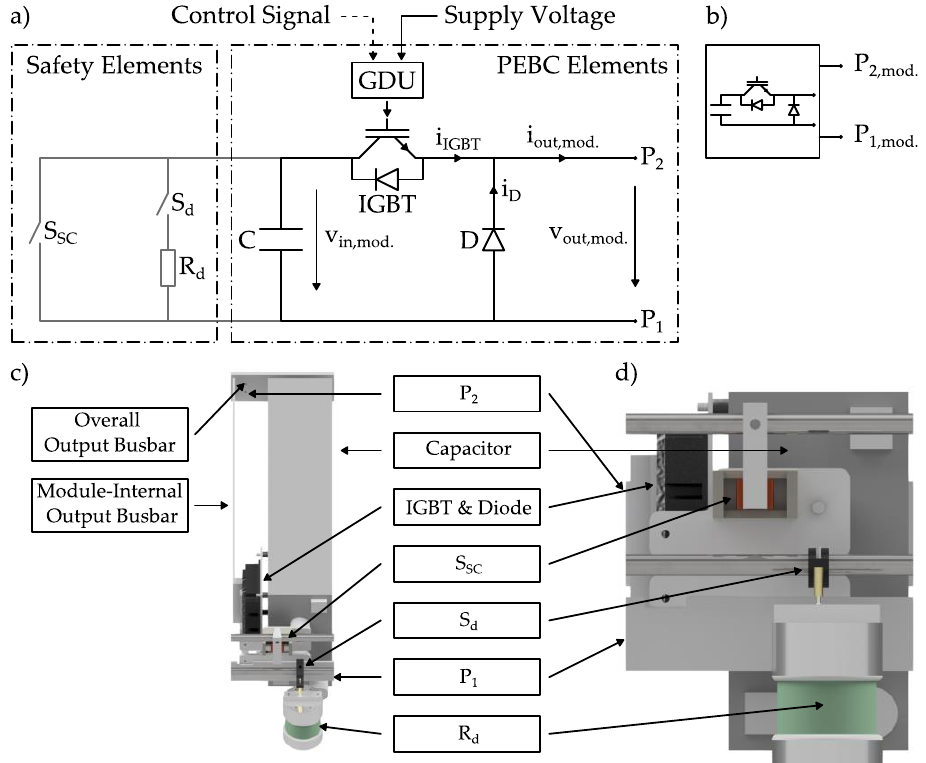
Figure 4. Equivalent circuit diagram of the developed individual PEBC module in ( a ) detailed and ( b ) simplified representation as well as rendering of physical PEBC module from demonstrator high-power test circuit in ( c ) isometric and ( d ) front view.